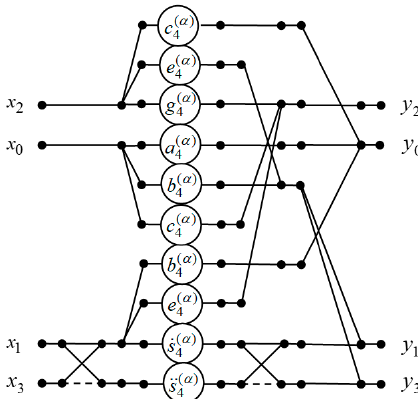
Figure 3. The data flow structure of the processing unit for the computation of the four-point DFrFT.